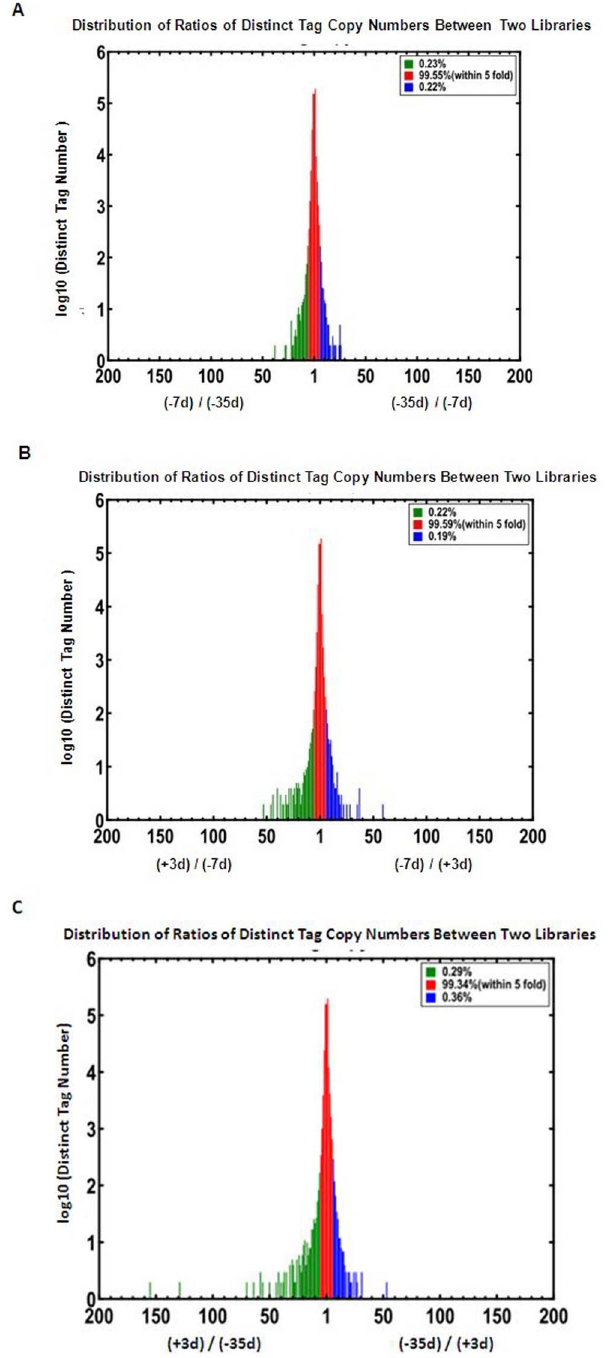
Figure 4. Differentially expressed tags at the onset of lactation. (A) Differentially expressed tags at 2 7 d compared with 2 35 d. (B) Differentially expressed tags at + 3 d compared with 2 7 d. (C) Differentially expressed tags at + 3 d compared with 2 35 d. The ‘‘x’’ represents the fold-change of differentially expressed unique tags. The ‘‘y’’ axis represents the number of unique tags (log10). The red region represents differentially accumulating unique tags with a 5-fold difference between libraries. The green and blue regions represent unique tags that are upregulated and downregulated for more than 5